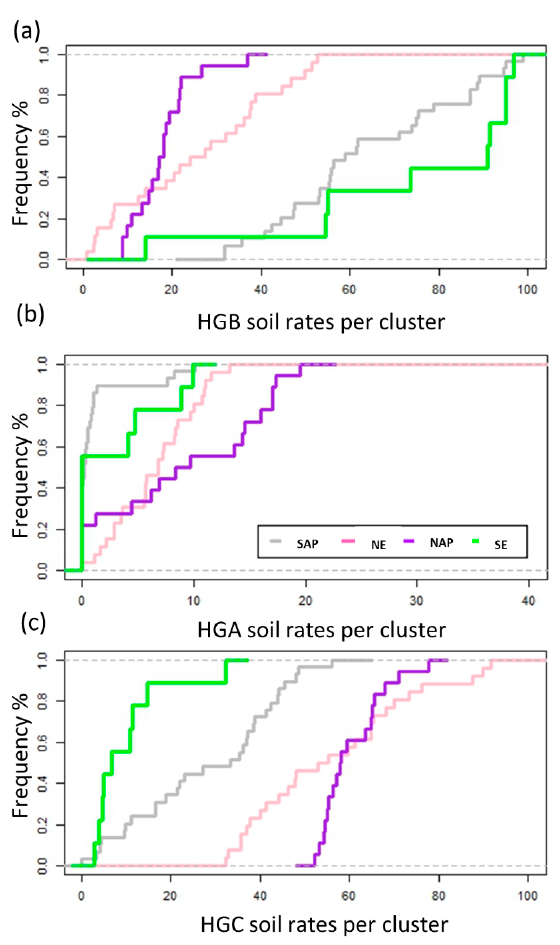
Figure 6. Cumulative Distribution Functions (CDFs) of proportions of different soil hydrologic groups across the study regions ( a ) CDFs of HGB, ( b ) CDFs of HGA, ( c ) CDFs of HGC. NE stands for north east, N.AP. stands for North Appalachian, S.AP. stands for south Appalachian, SE stands for south east.